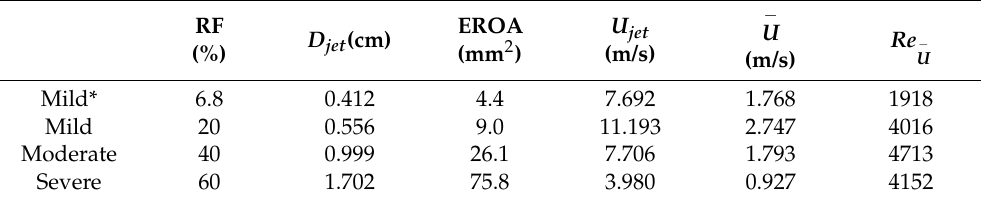
Table 1. Details of four simulation cases. D jet is the length of major axis. U jet and velocity and mean velocity, respectively, of regurgitant jet. Re − the mean velocity.